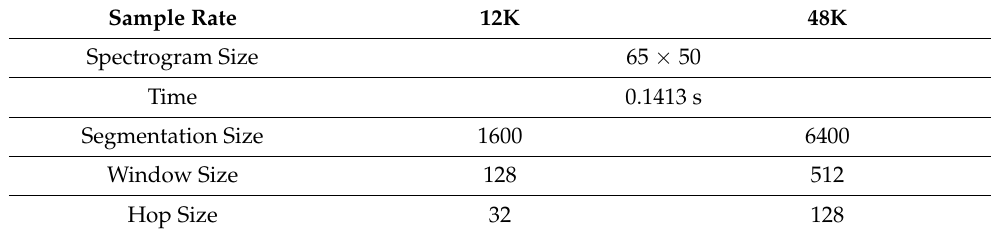
Table 1. Parameters for each spectrogram with different sizes and corresponding time intervals.